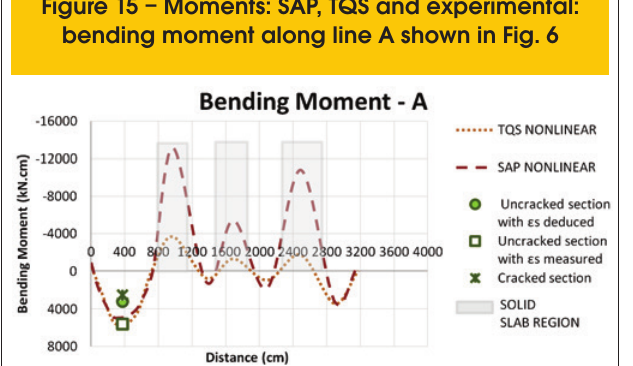
Figure 15 – Moments: SAP, TQS and experimental: bending moment along line A shown in Fig.